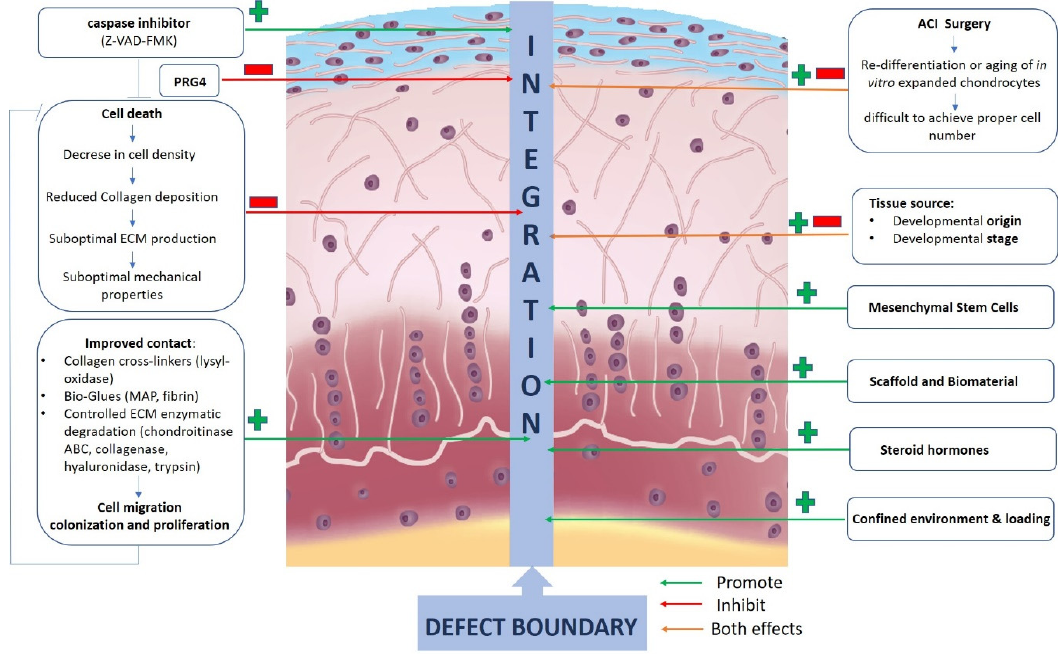
Figure 4. Factors involved in cartilage integrations. Articular cartilage image modified permission from M.J. Stoddart et al., 2009 [1].